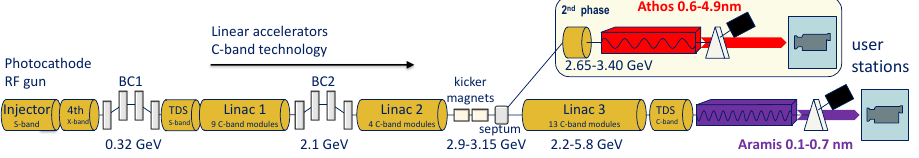
Figure 1. SwissFEL accelerator layout. It consists of an S-band injector, a C-band linear accelerator, and two undulator lines. The details of these components are described in the following